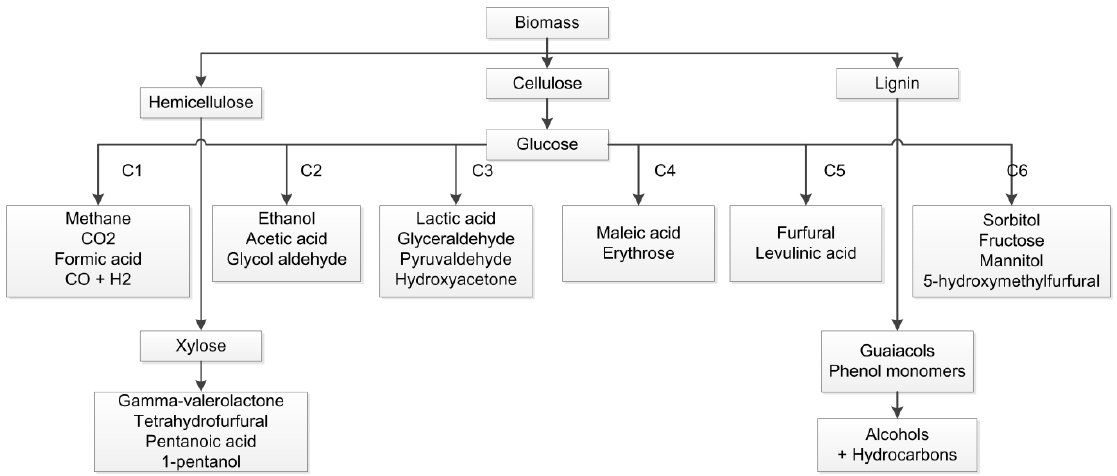
Figure 6. Top Chemical Building Block Candidates from Biomass, adapted from [37].